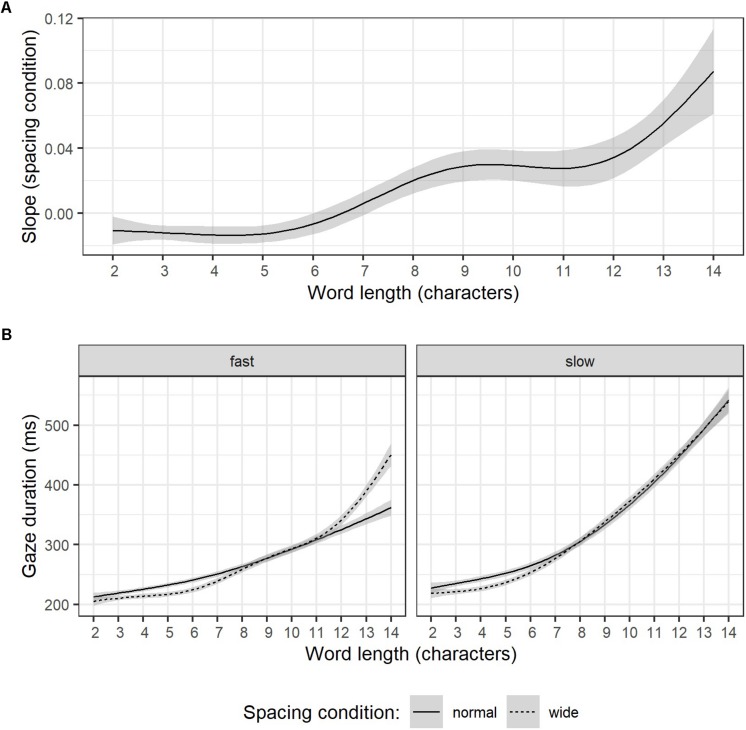
Word specific slopes estimates of character spacing (LMMs for gaze duration) as a function of word length (A). Illustration of word length effects on gaze duration for relatively fast (left) and slow readers (right) for normal (solid line) and wide (dashed line) character spacing (B). Note, words longer than 14 characters were omitted because too few items per length category were available. Error corridors represent the pointwise 95% confidence interval on the fitted values of the generalized additive model smooth lines.